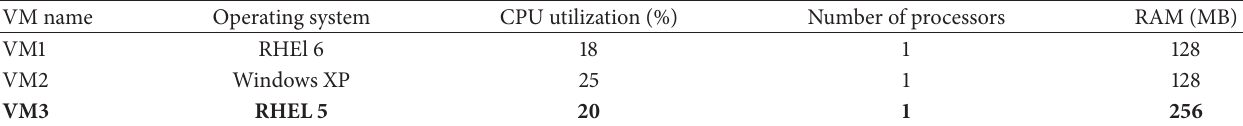
Table 11: Local list of node 2 (S1).